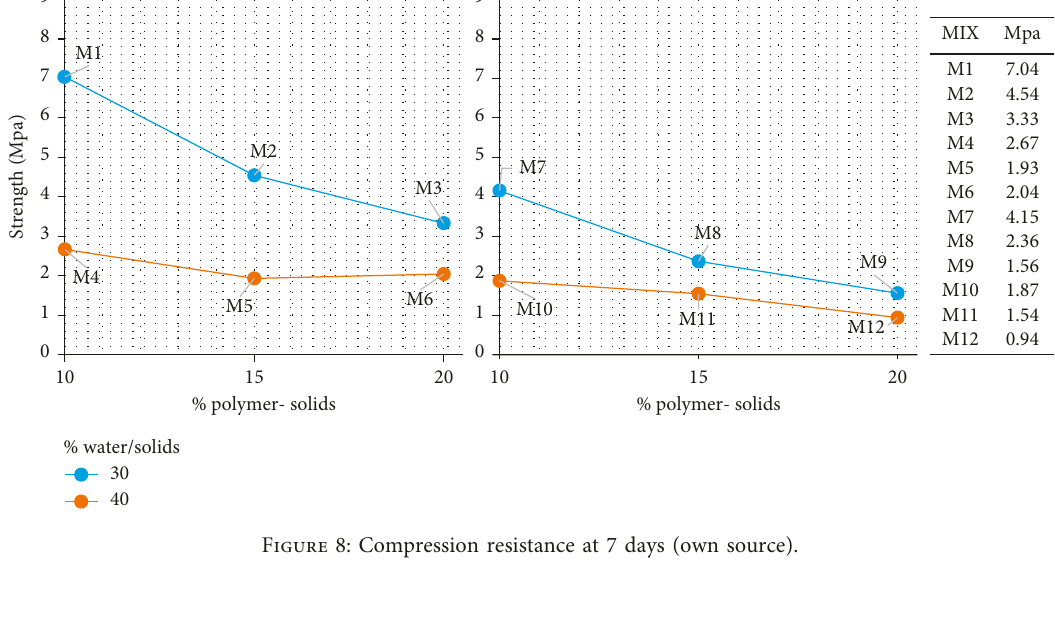
Figure 8: Compression resistance at 7 days (own source).